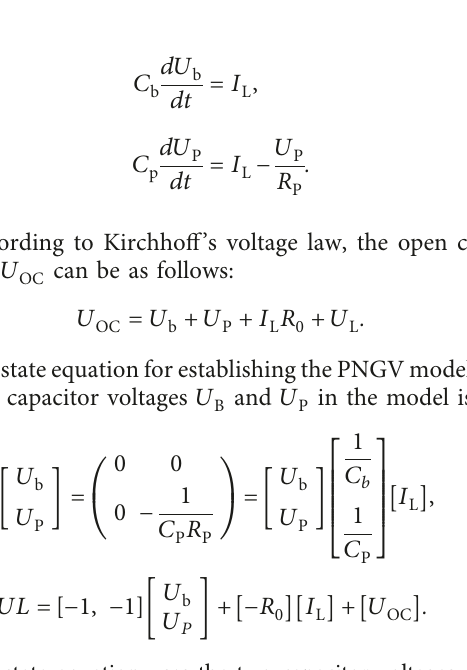
Figure 5: PNGV equivalent circuit